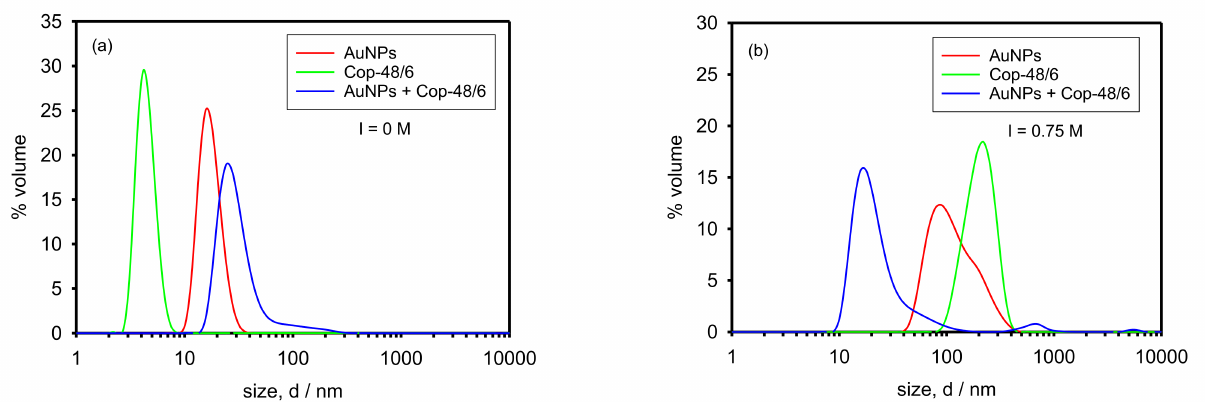
Figure 5. Size distribution by volume of the nanocomposite (AuNPs + Cop-48/6) at 25 ◦ C. ( a ) Without added salt, and ( b ) with NaCl concentration 0.75 M. For an illustrative comparison, distributions of AuNPs and Cop-48/6 are also